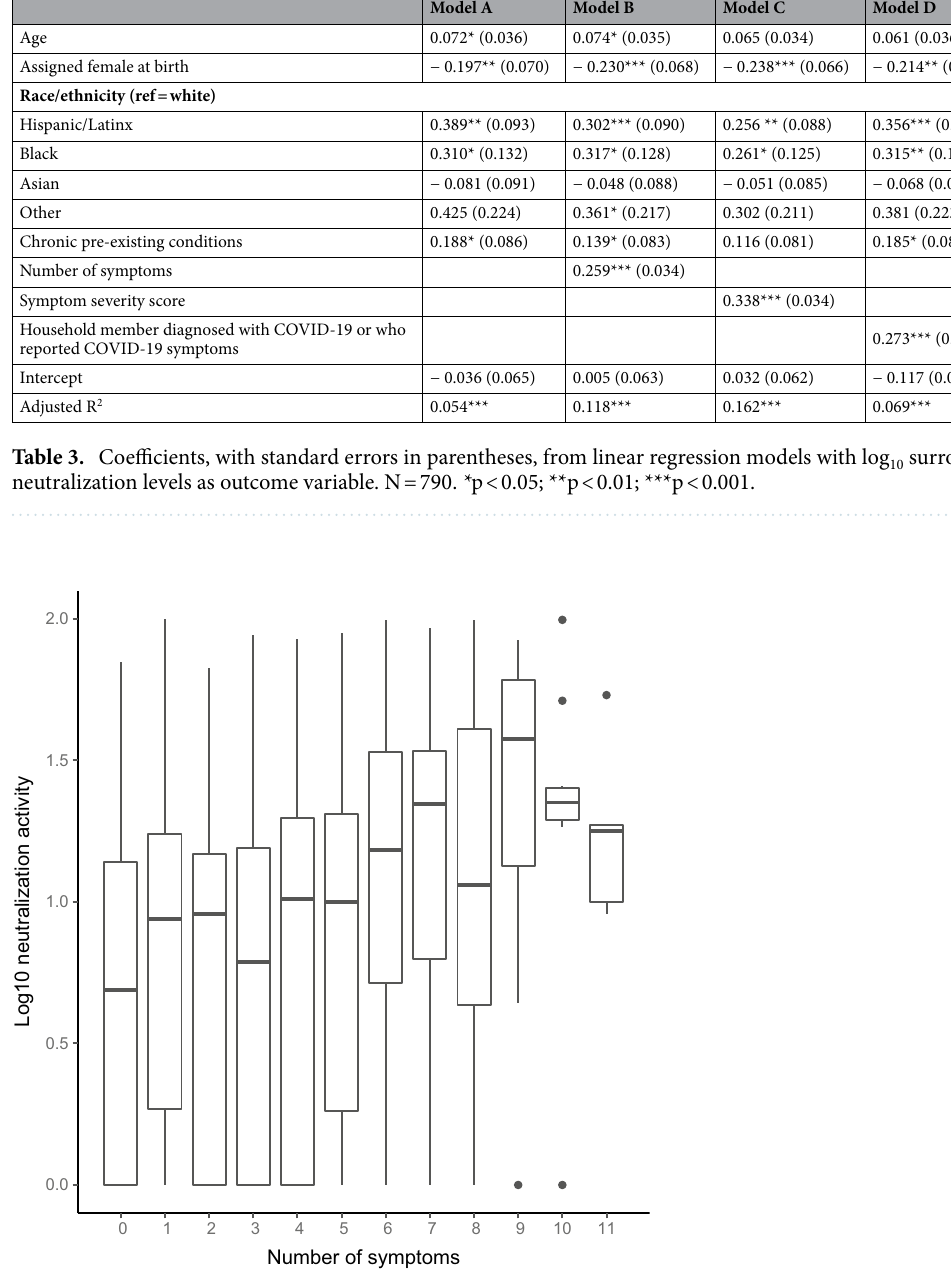
Figure 1. Percent inhibition of Spike-ACE2 binding in association with number of reported symptoms in seropositive individuals. Boxplot indicating mean, interquartile range, and outlier measurements of log10- corrected surrogate neutralization levels for seropositive participants who reported 0–11 symptoms of COVID- 19 infection 21 . N =